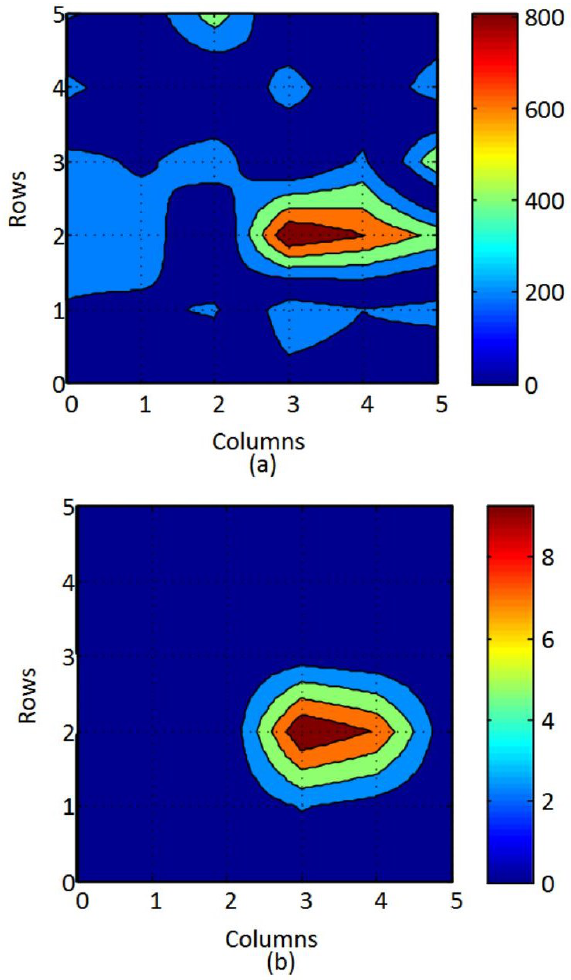
Fig. 12. Compaction stains mapping through Lateral Profiling method ( ρ a